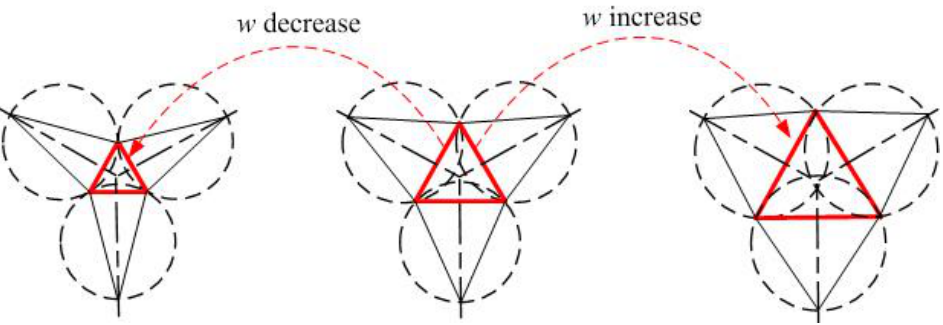
Figure 2. The process of the similarity transformation based on origami.